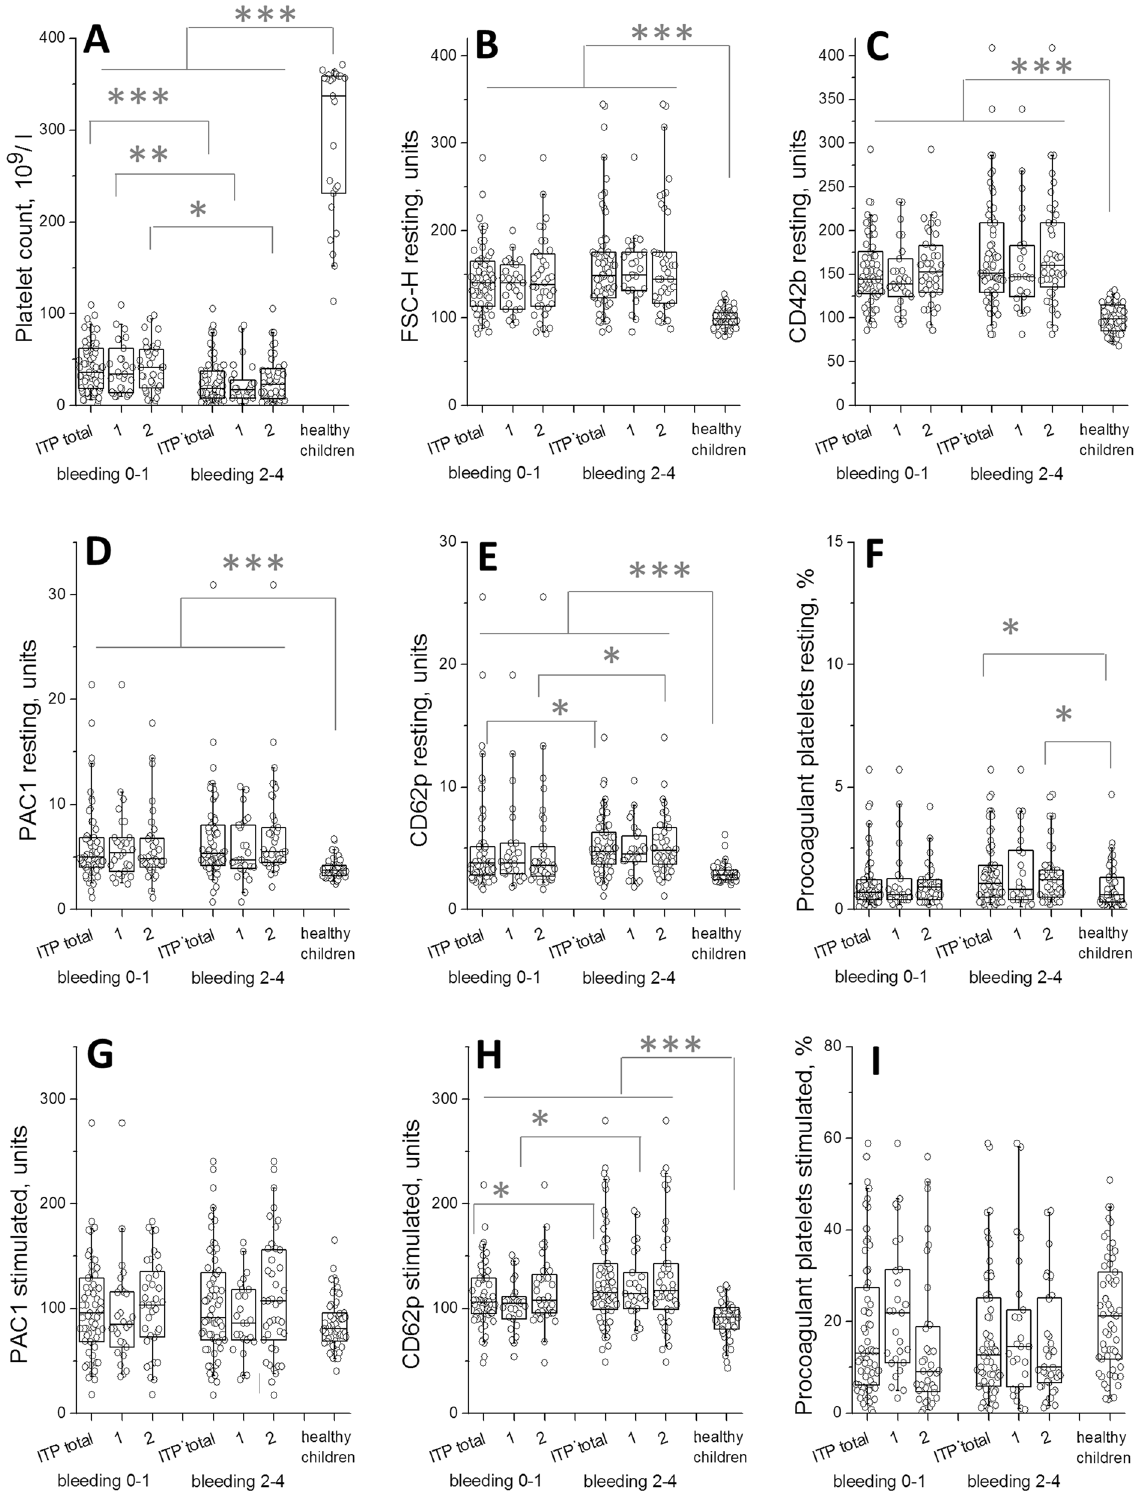
Figure 2. Platelet function and bleeding in ITP patients not on romiplostim. Comparison of the platelet function parameters for acute/persistent ITP (labeled as 1) and chronic ITP labeled as 2) in resting state and upon stimulation by CRP + TRAP-6 mixture. Statistics is as in Fig.